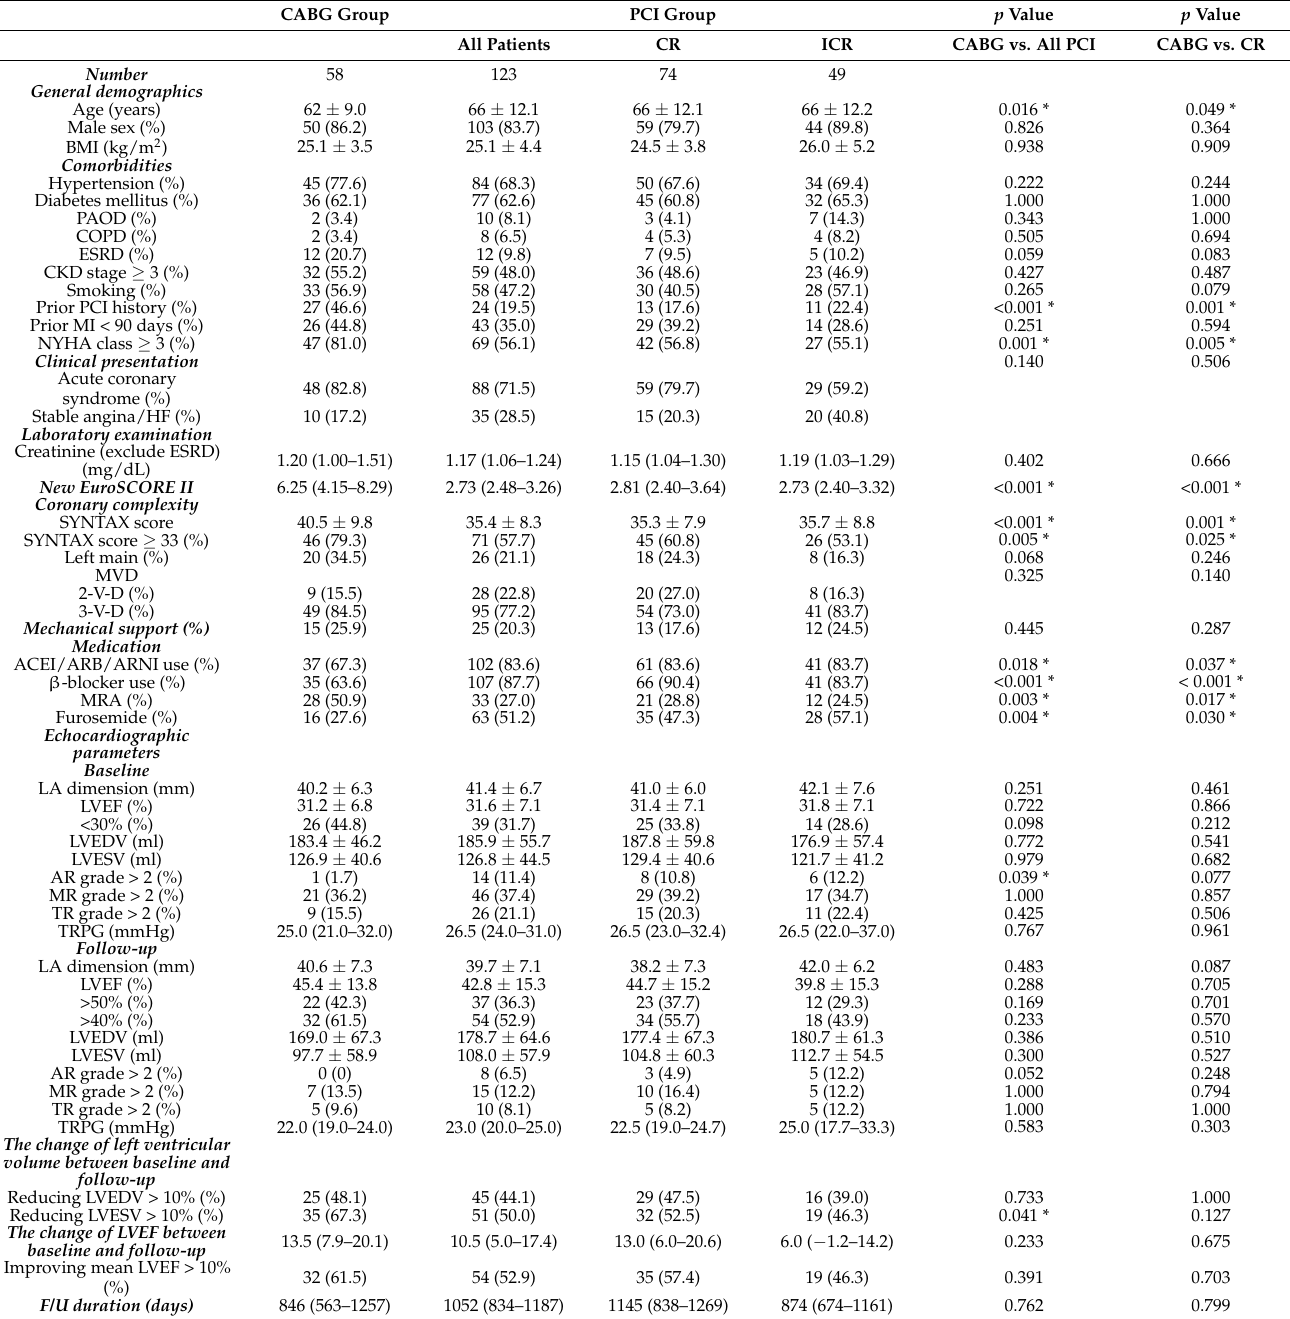
Table 1. Baseline characteristics and echocardiographic parameters of the study